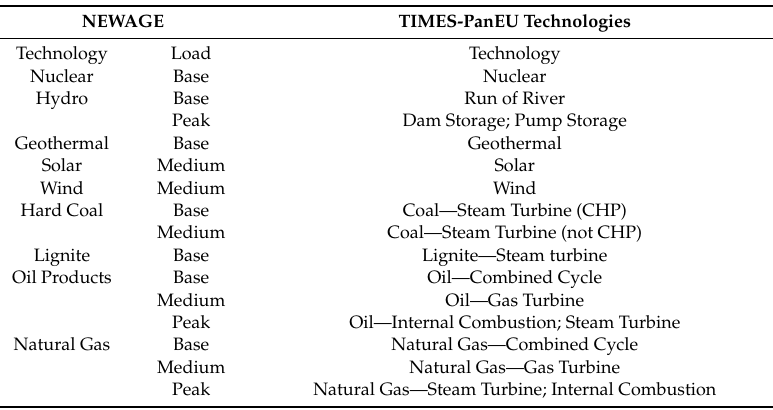
Table A4. Electricity technology match NEWAGE and TIMES